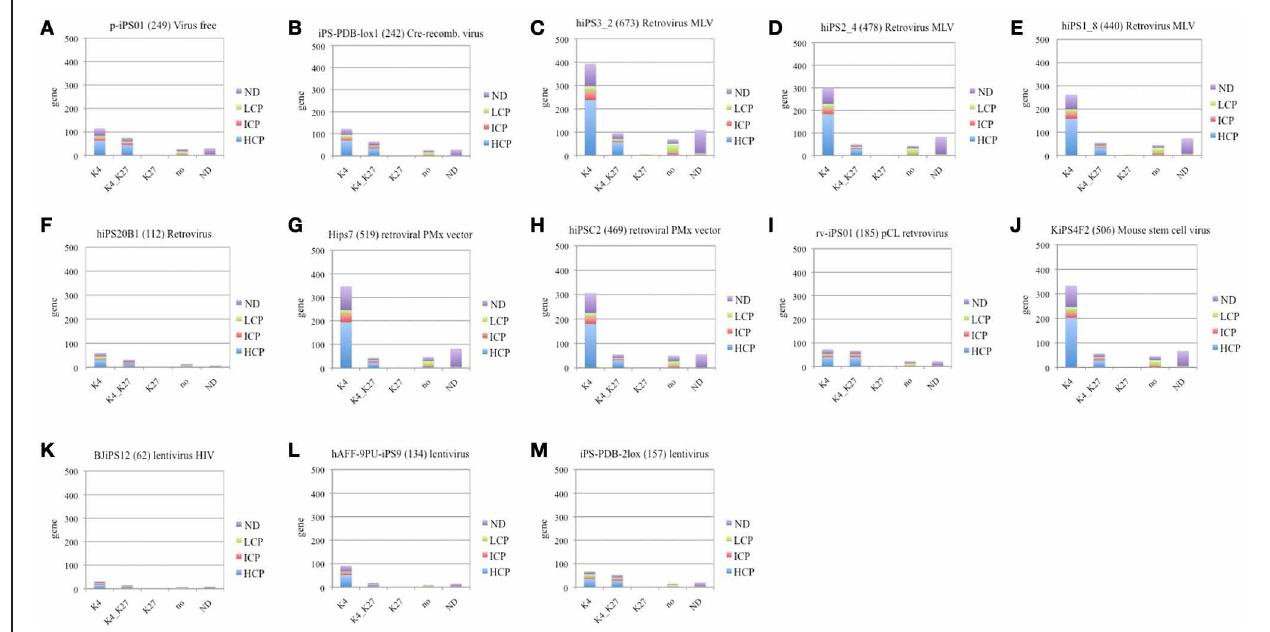
FIGURE 3 | Classification of iPS cell down-regulated Inherited genes according to the histone H3 methylation status in ES cell and CpG promoter density. (A) virus free (B) cre-recombinase excisable virus, (C–J) retrovirus, and (K–M) lentivirus. Figure legends specifications for methylation status of histone 3 (H3) in ES cell: “K4”—trimethylation of lysine on residue 4, “K4_K27”—trimethylation